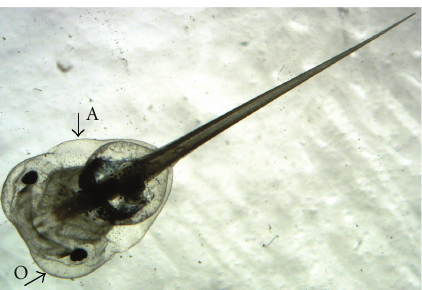
Figure 1: Edema in optic and abdominal areas of X. laevis tadpole caused by all nominal Zn exposure concentrations (2.73, 5.46, 10.91, and 21.83 mg/L), except for the lowest one (1.36mg/L). O: optic and A: